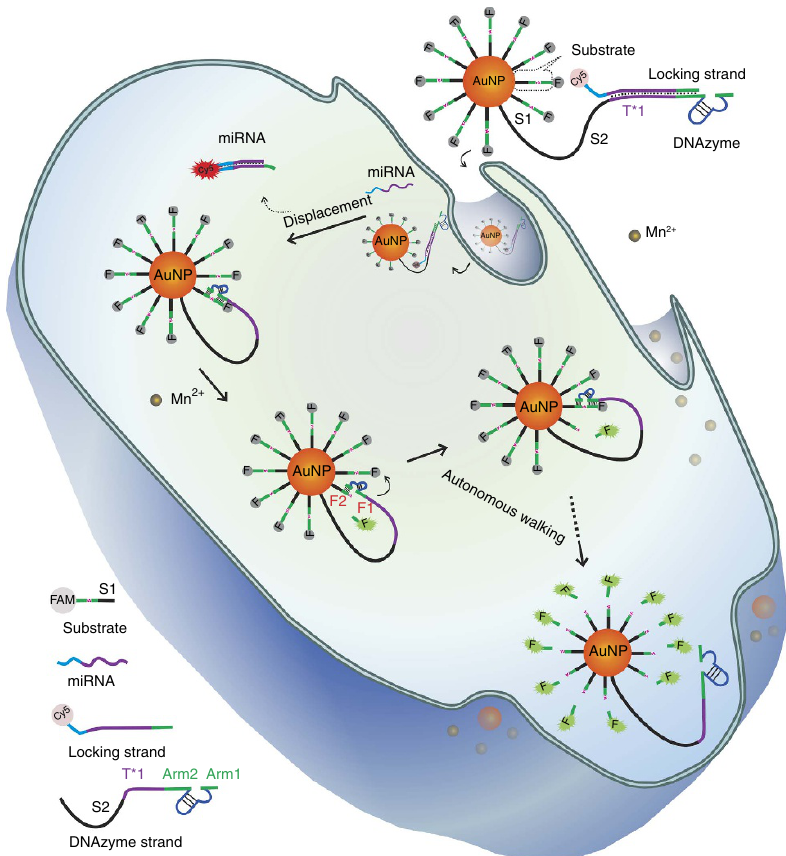
Figure 1 | Intracellular operation of a DNAzyme motor initiated by a specific miRNA. The DNAzyme motor system is constructed on the AuNP. The AuNP is functionalized with hundreds of substrate strands and dozens of DNAzyme molecules that are each silenced by a locking strand. Inside the cells, the target miRNA hybridizes to the locking strand and releases the locking strand from the DNAzyme through a strand displacement reaction. The unlocked DNAzyme subsequently hybridizes to its substrate. The cofactor Mn 2 þ activates the DNAzyme, which cleaves the substrate, generating two DNA segments F1 and F2 . The FAM-containing F1 segment is released from the AuNP surface, restoring its fluorescence that is previously quenched by the AuNP. Meanwhile, the DNAzyme dissociates from F2 and subsequently hybridizes to the next substrate strand, achieving the walking of the motor from one substrate strand to the next. This stepwise walking is repeated autonomously, driving the DNAzyme motor to traverse along the AuNP surface. Monitoring the fluorescence of FAM provides real-time imaging of the intracellular operation of the motor in live